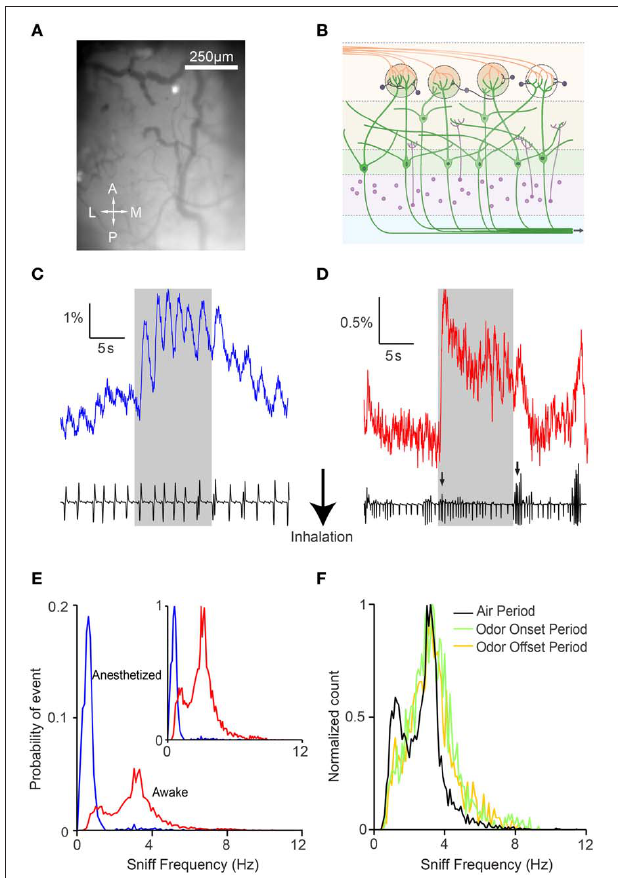
FIGURE 1 | Awake GCaMP2 mice display dynamic sniffing behavior compared to anesthetized mice. (A) Average-intensity image of the olfactory bulb in the absence of odor stimulation. A, anterior; L, lateral; M, medial; P, posterior. (B) Schematic showing the expression of GCaMP2 in M/T cells. (C) Fluorescence time course of a single glomerulus in an anesthetized mouse with the corresponding nasal air pressure tracing. Gray shaded area represents the period of odor stimulation. (D) Fluorescence time course and sniff tracing for an awake mouse. Arrows indicate sniff bursts immediately after odor onset and offset. (E) Distribution of sniff frequencies in anesthetized (blue) and awake (red) mice. Inset depicts the same histogram normalized to the peak frequencies. (F) Normalized distribution of sniff frequencies in awake mice during the air period (black), odor onset period (green), and odor offset period